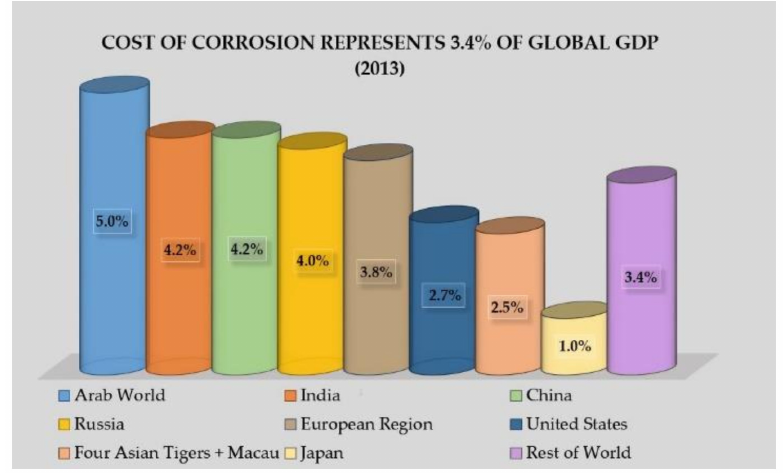
Figure 1. Global costs of